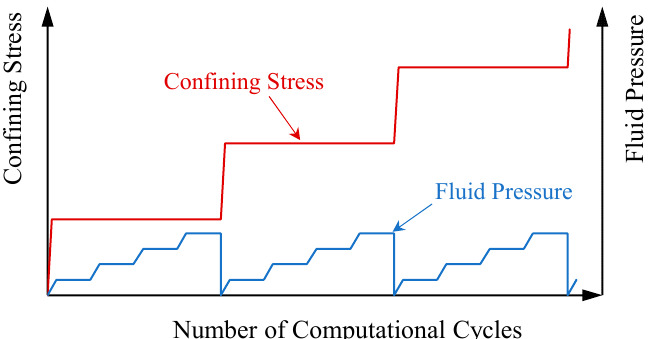
Figure 11. Schematic view of the modeling procedure for sand production simulation. The LBM parameters used in the simulation of the fluid flow are presented in Table 4.